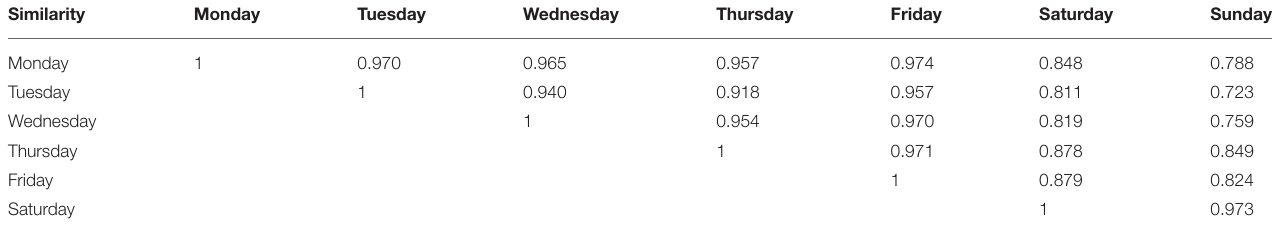
TABLE 3 | Daily correlation in 1 week.